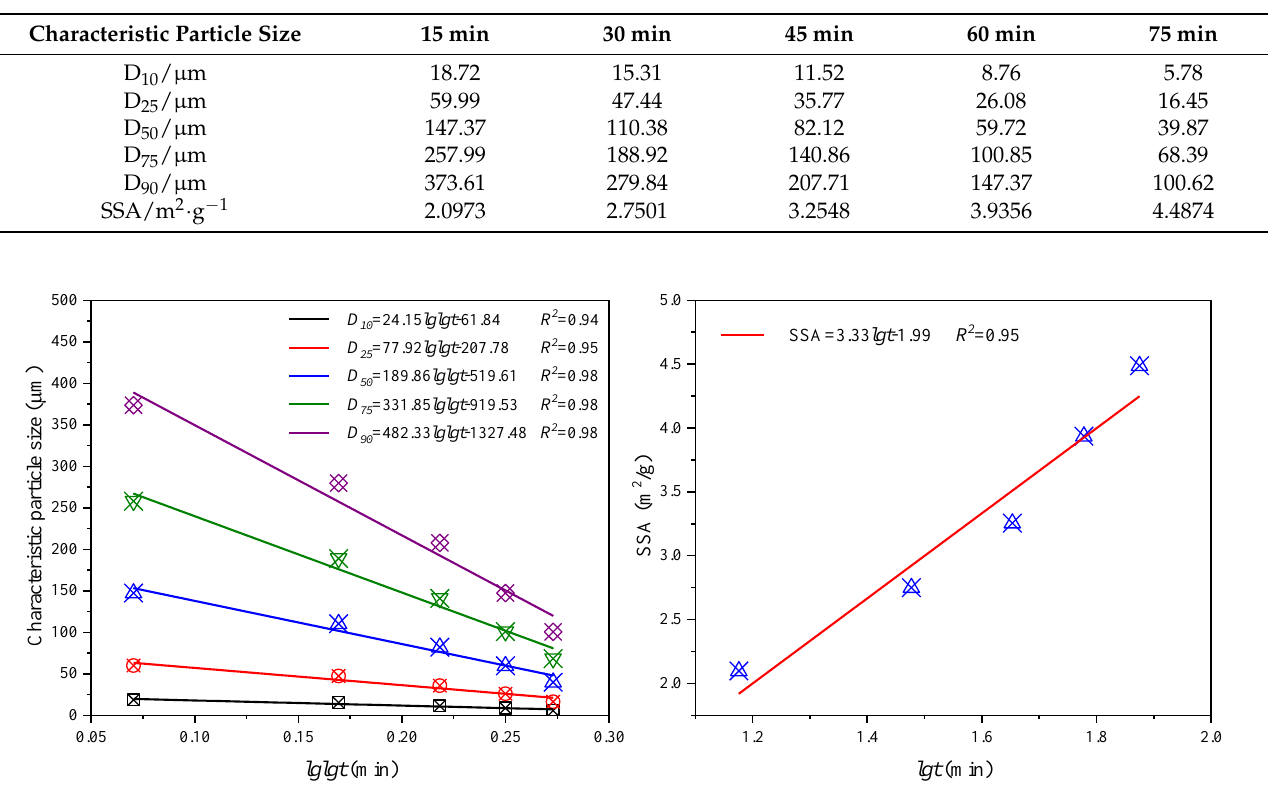
Table 5. Characteristic particle size and SSA of CGS at different grinding time.